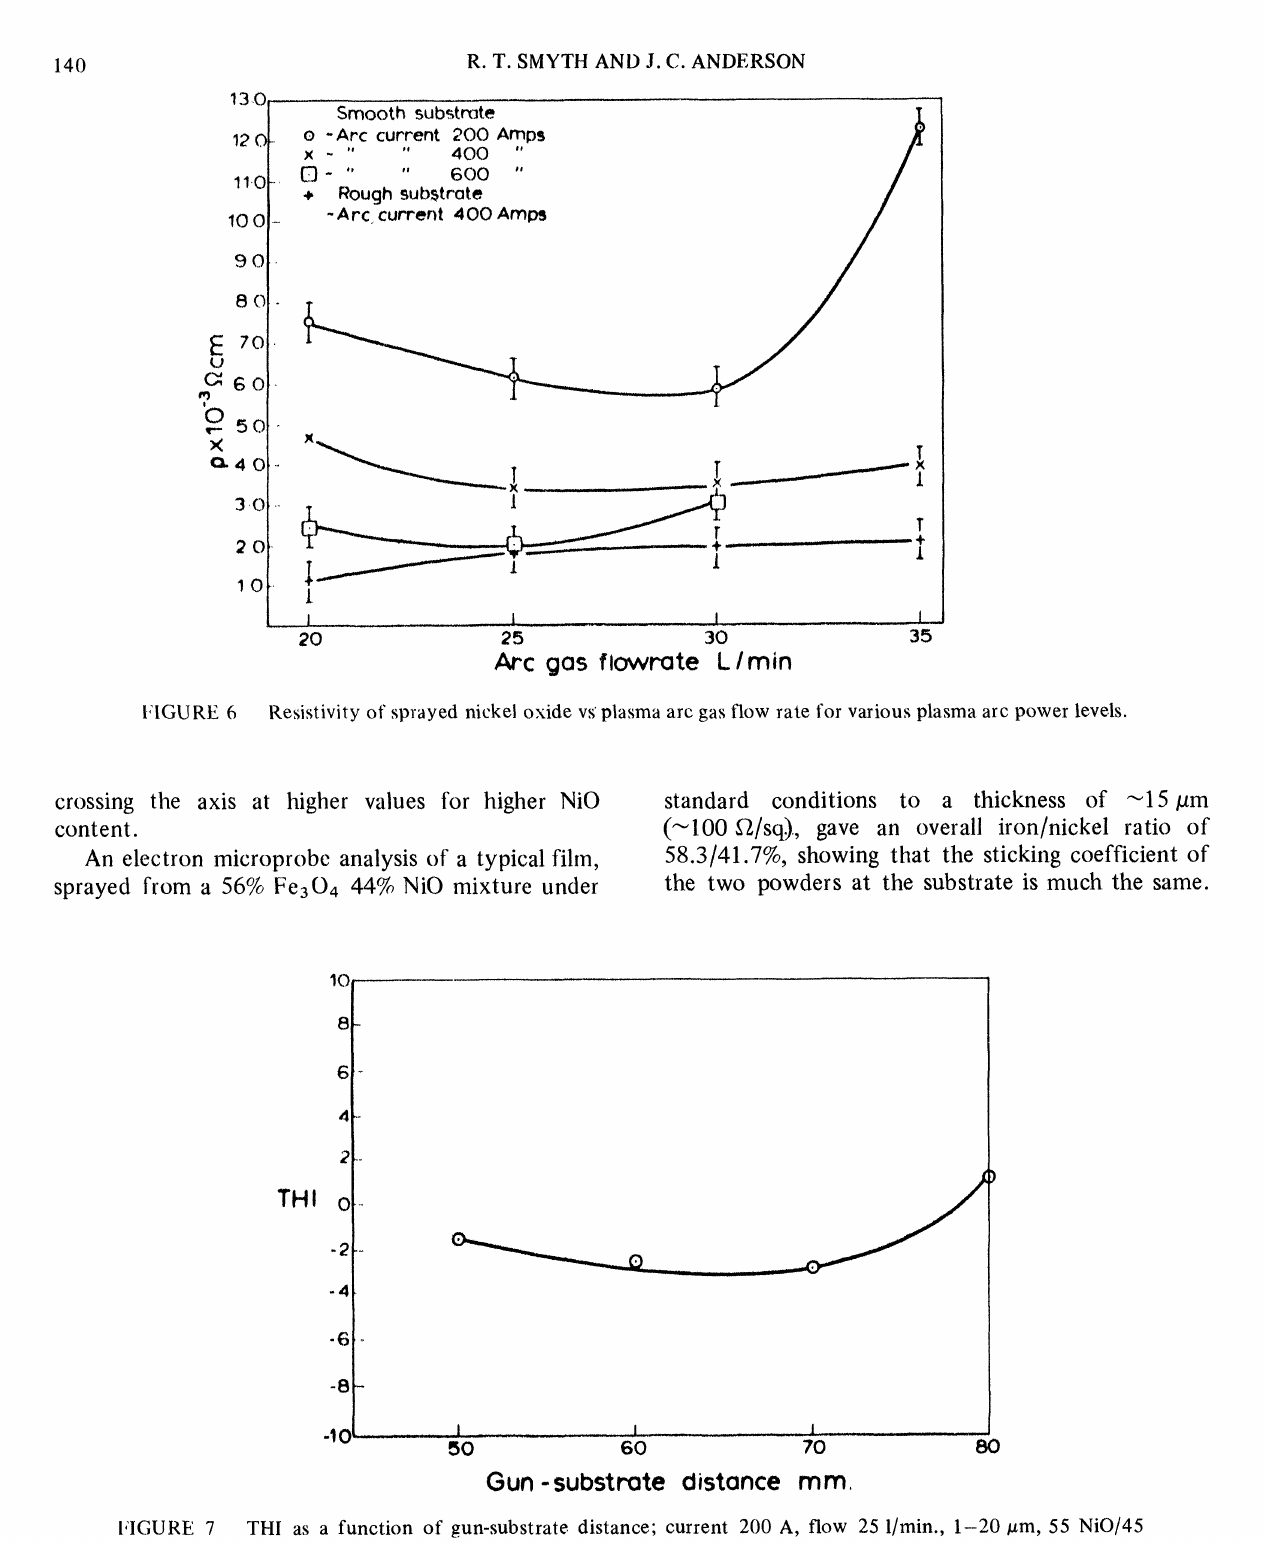
THI as a function of gun-substrate distance; current 200 A, flow 25 1/min., 1-20 #m, 55 NIO/45 Fe. O4 powder, smooth